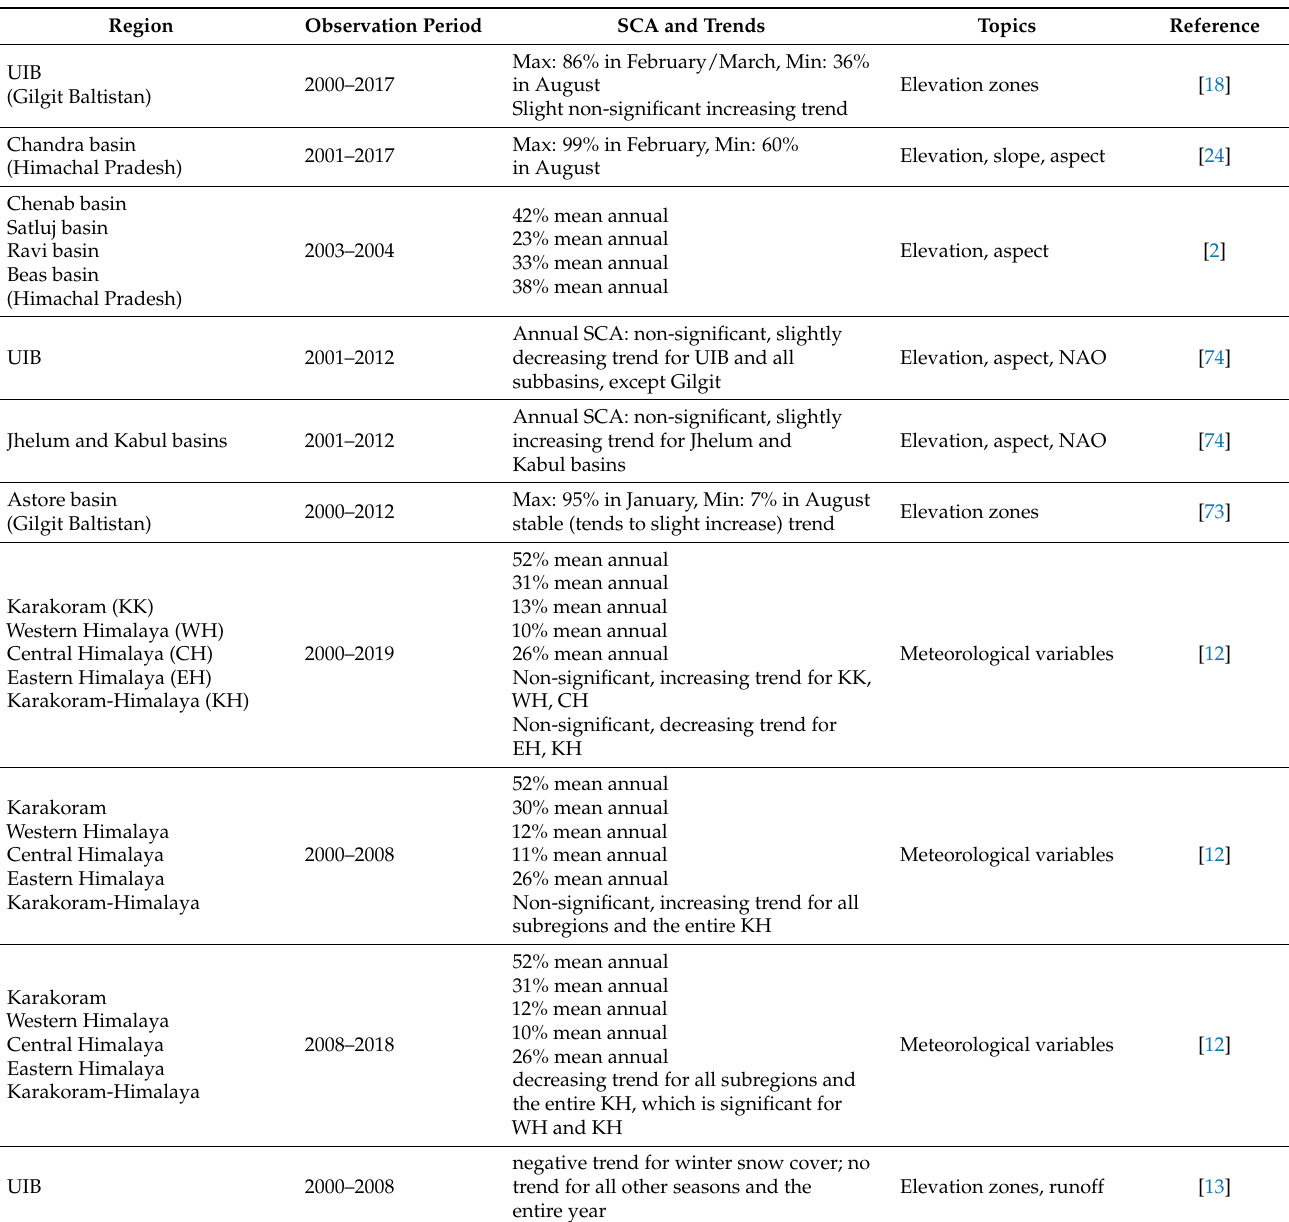
Table 4. Selected studies focusing on snow cover distribution and trends in the high mountain regions of South